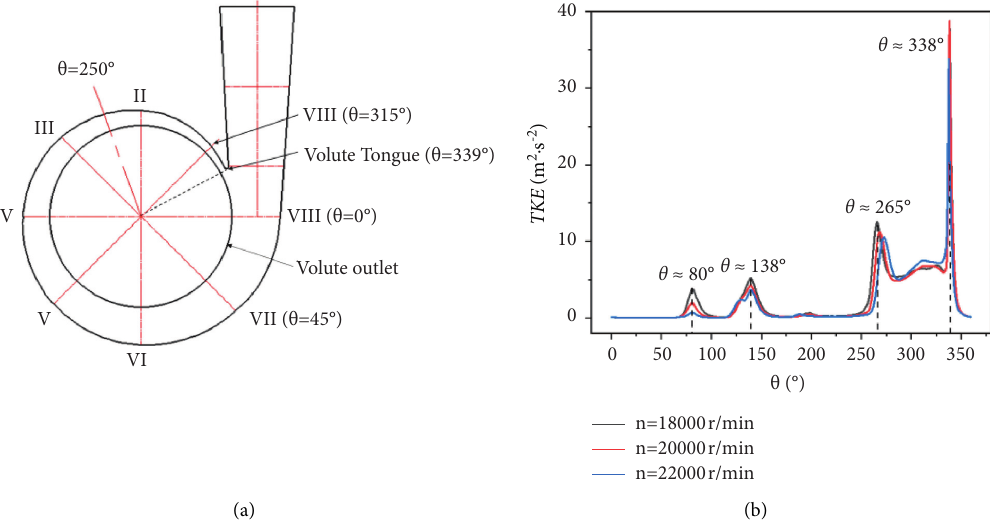
Figure 13: The centrifugal TKE distribution of volute outlet. (a) Schematic diagram in middle section of volute. (b) Circumferential TKE